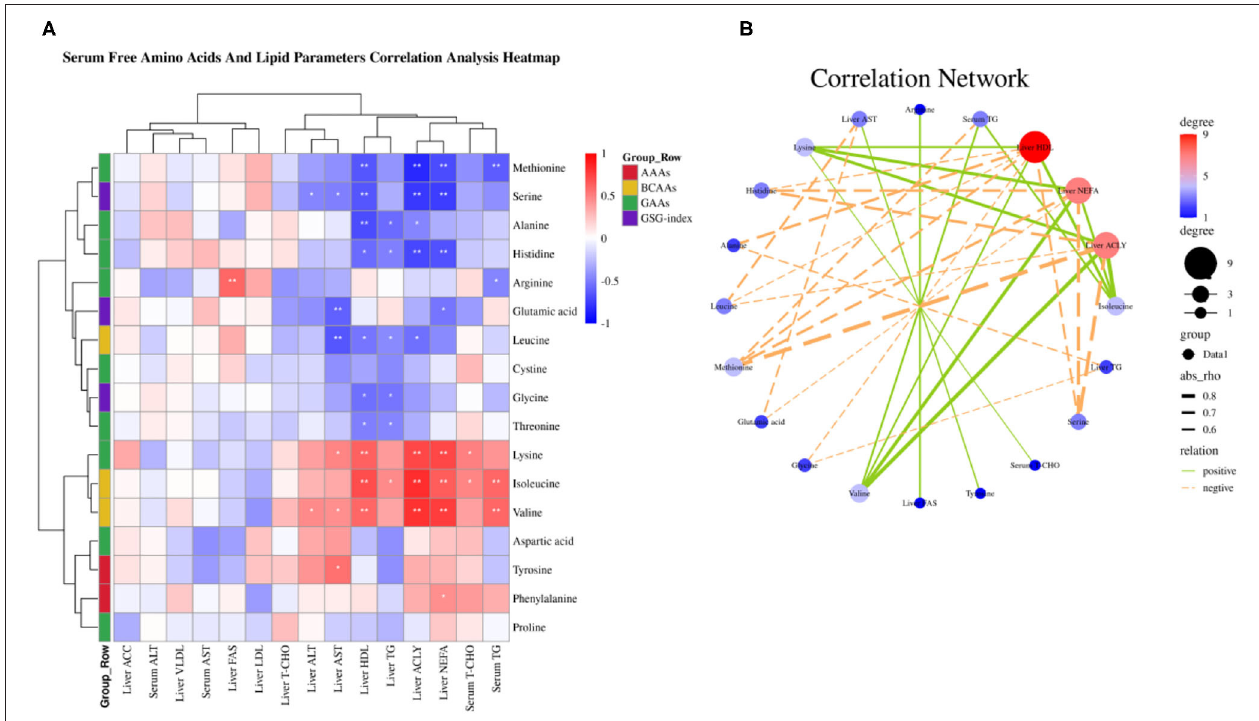
FIGURE 4 | Serum-free amino acids and lipid parameters correlation analysis. (A) Serum-free amino acids and lipid parameters correlation analysis heatmap. (B) Correlation network. * P < 0.05 and ** P < 0.01.